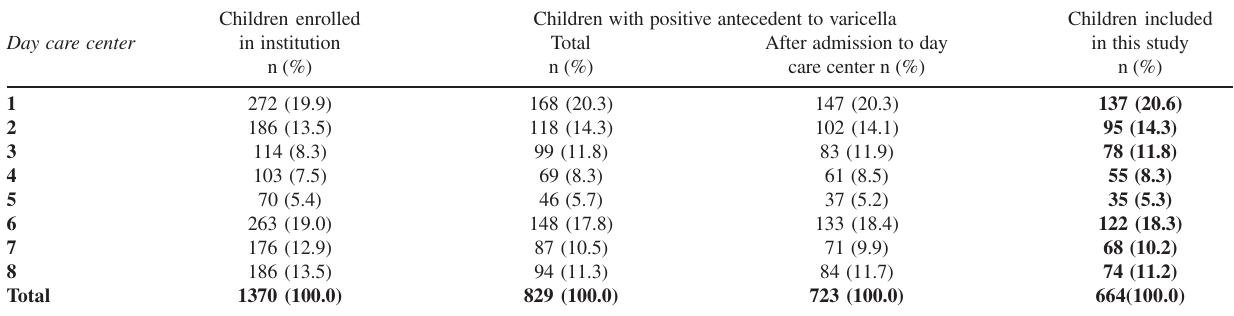
Table 1 - Number (n) and proportion (%) of children by institution, clinical history of varicella, and enrolled in this study